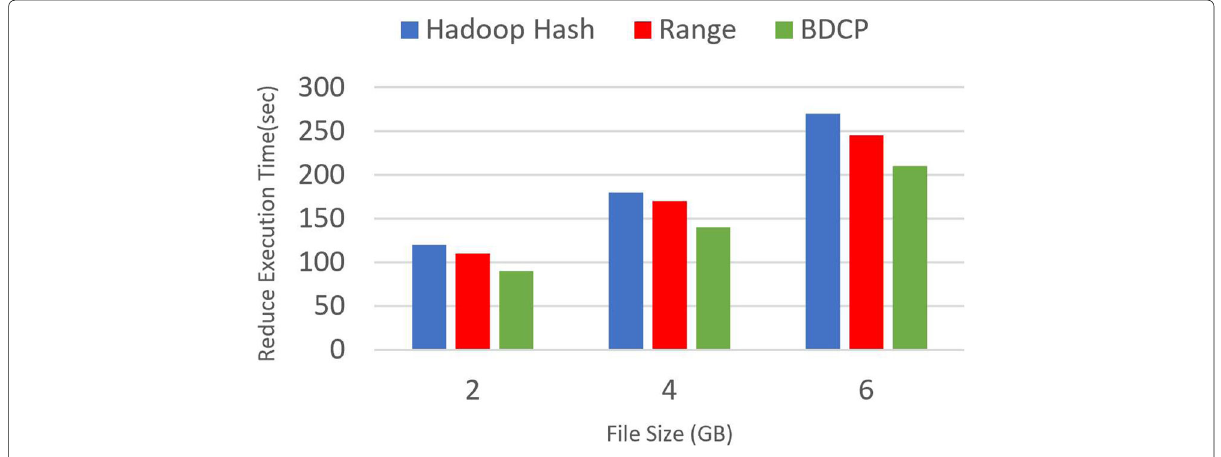
Fig. 17 Sort job on files of sizes, 2, 4, and 6 GB. Skew degree is 0.1